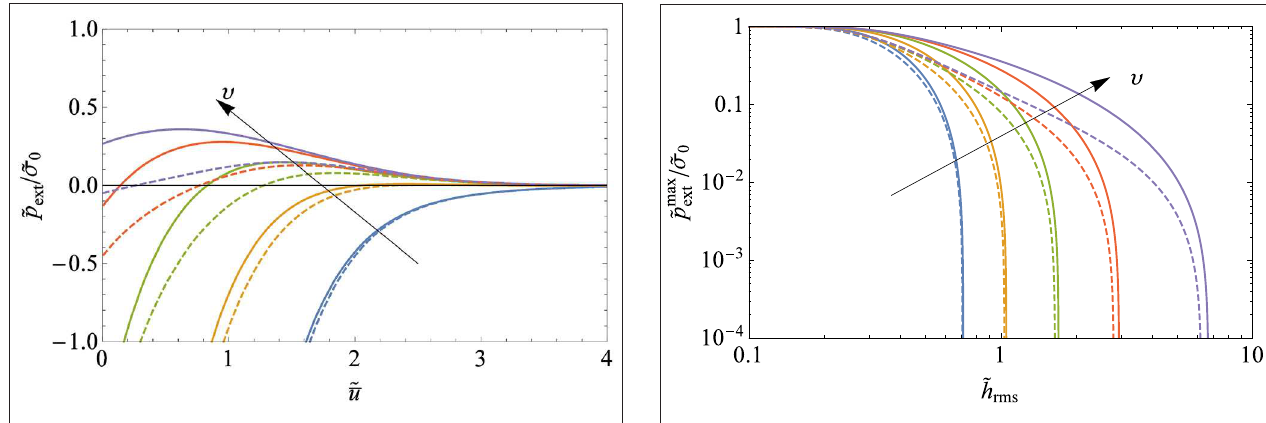
FIGURE 6 | Pull-off mean